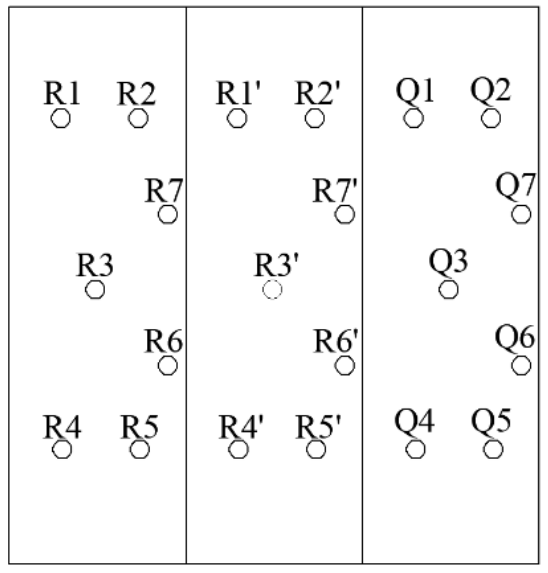
Figure 7. Layout of the temperature measuring points on the wall panels.